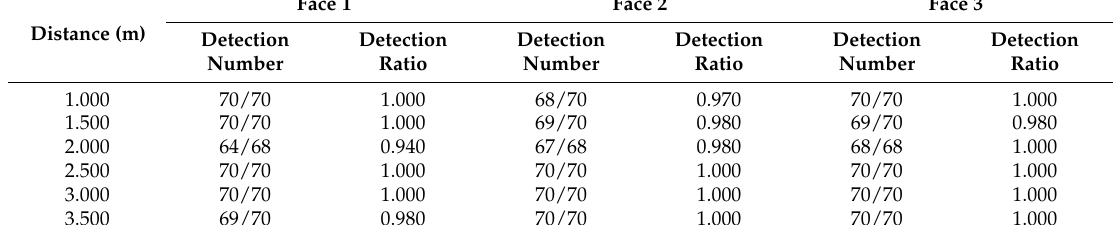
Table 2. F 1 score values for the proposed and benchmark algorithms at different distances.